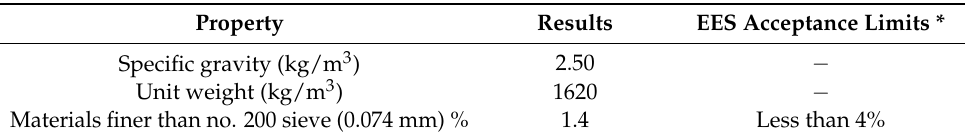
Table 2. Physical properties of the sand.